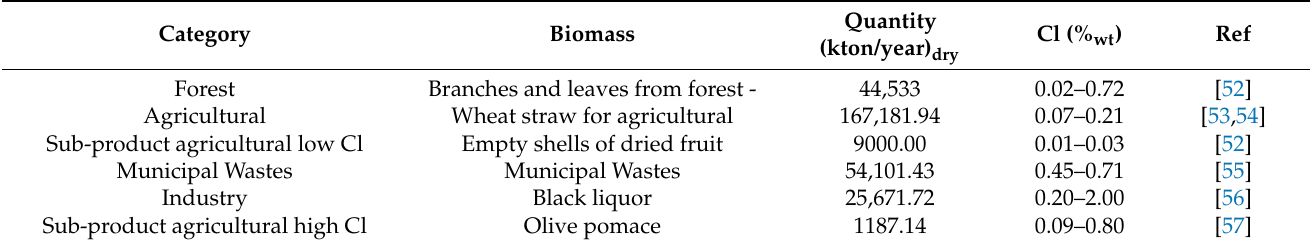
Table 1. Chloride content for the most common biomass